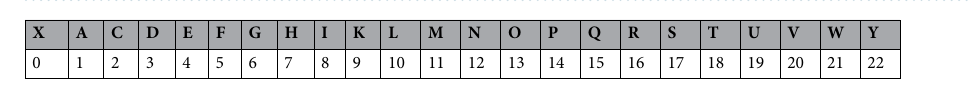
Figure 9. Two sample logo of Benchmark Dataset.